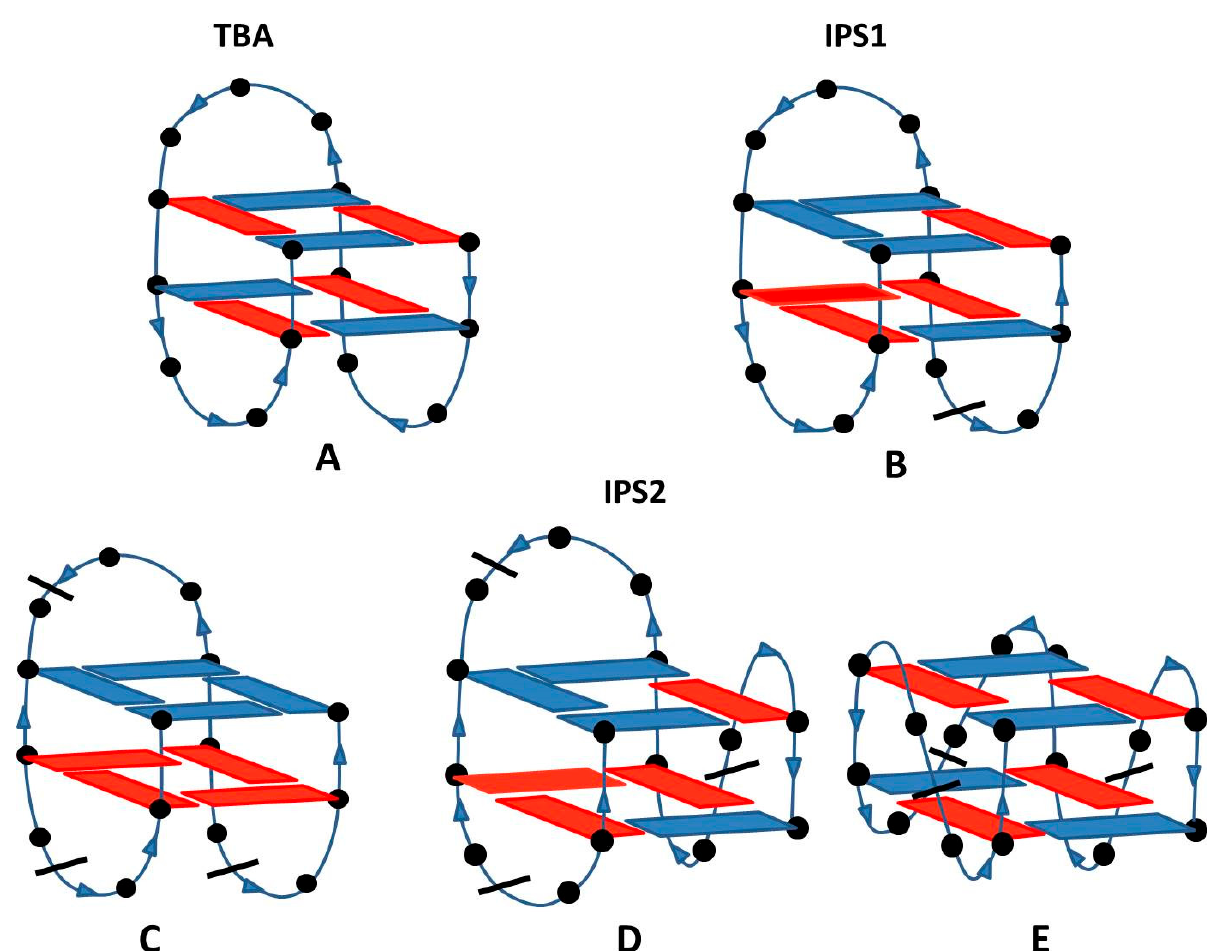
Scheme 1. Proposed structures formed by studied oligonucleotides: TBA ( A ), IPS1 ( B ) and IPS2 ( C , D or E ). Red and blue squares indicate syn and anti guanosine residues. Inversion of polarity sites are indicated by black line and 5 ′ -3 ′ orientation is indicated by arrows.